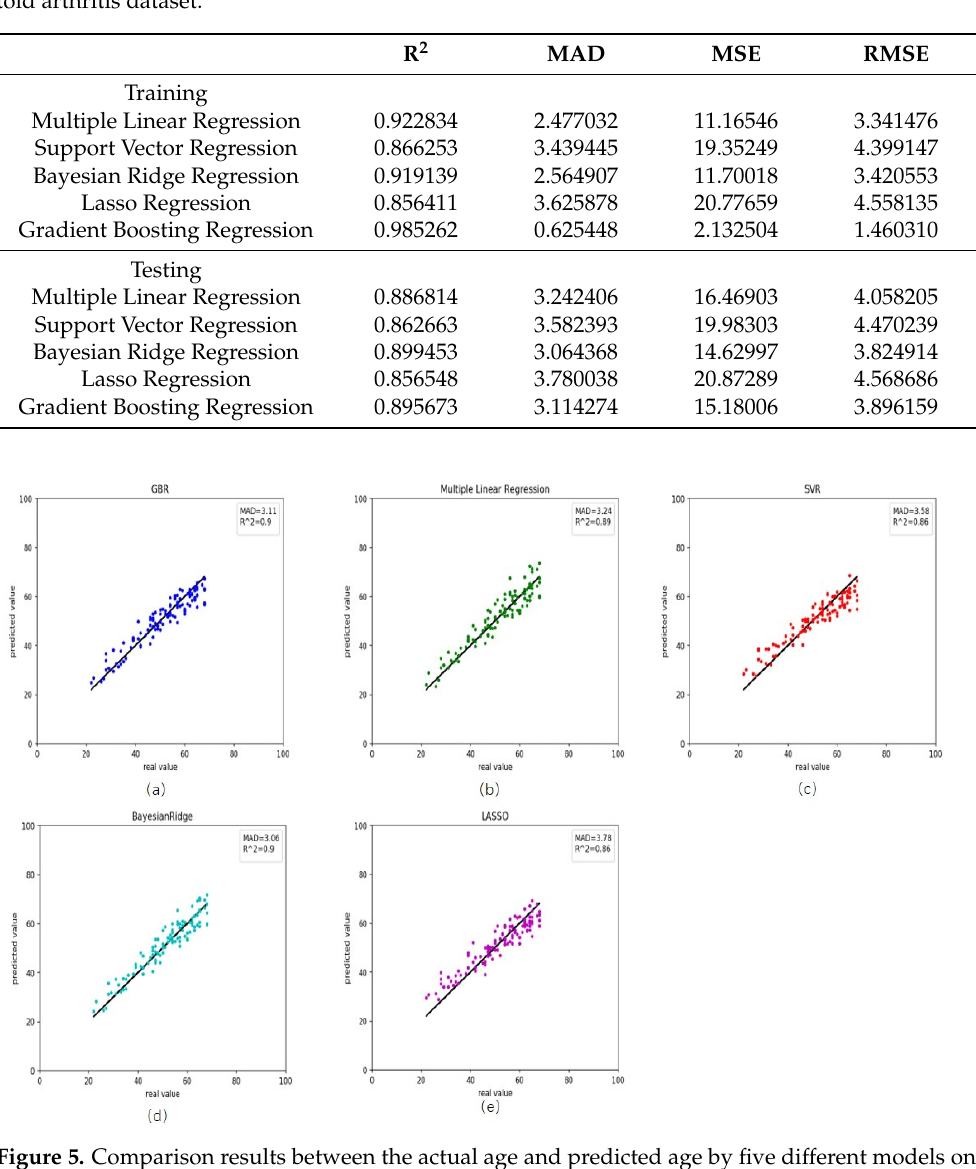
Table 4. Comparison results of our predictor with other four common regression models on rheuma- toid arthritis dataset.